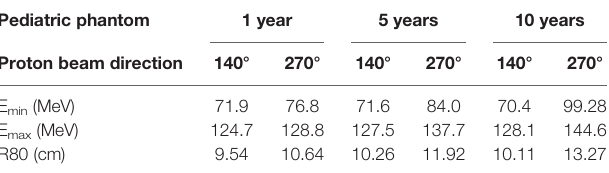
TABLE 2 | Proton beam speci fi